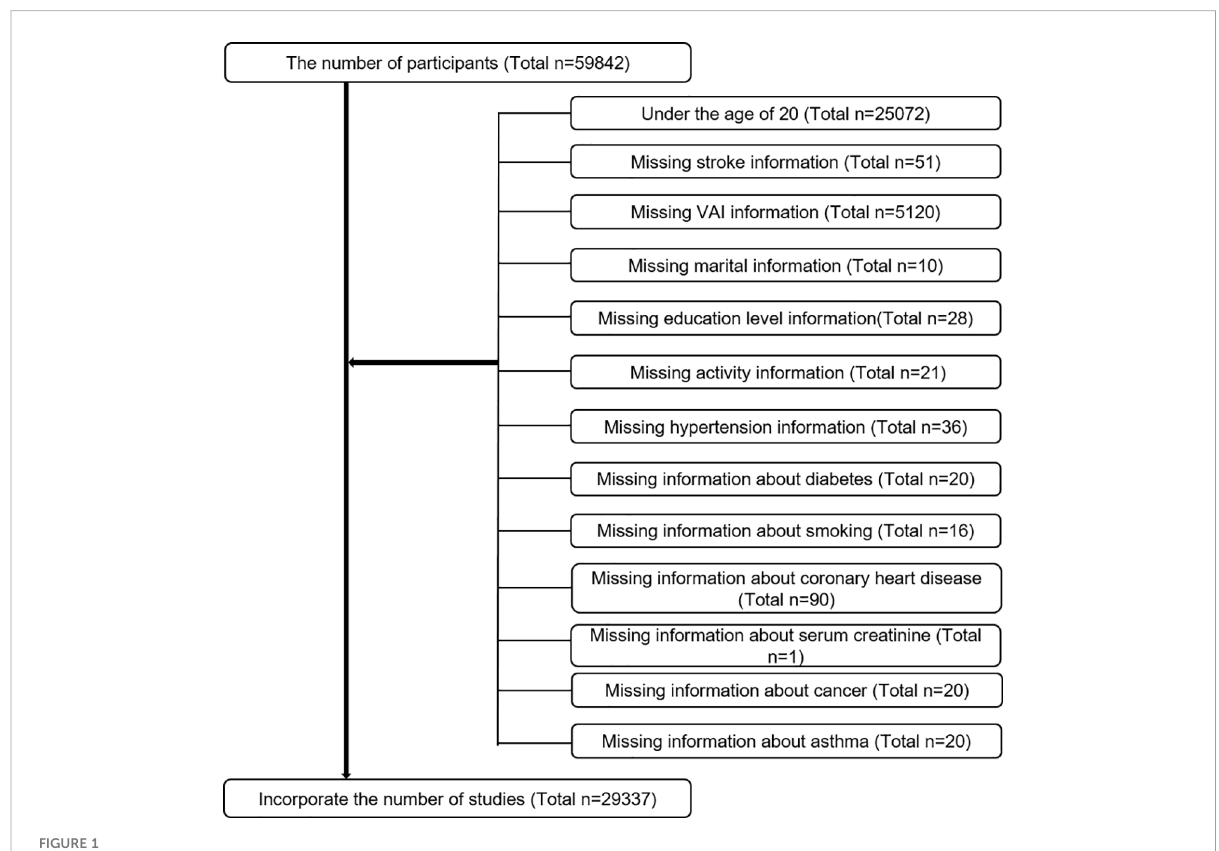
FIGURE 1 Sample selection process fl ow